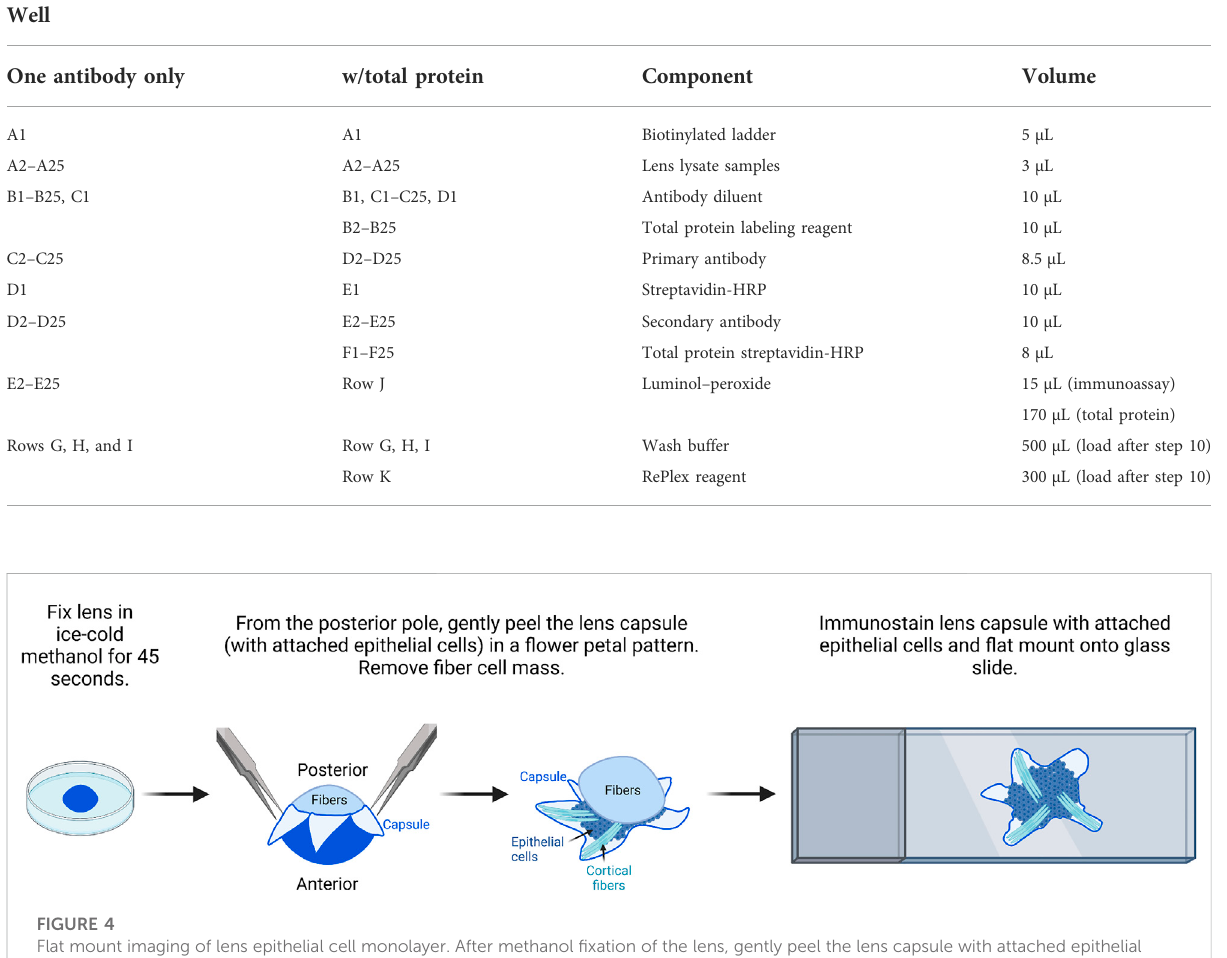
TABLE 1 JESS/WES plate loading guide.